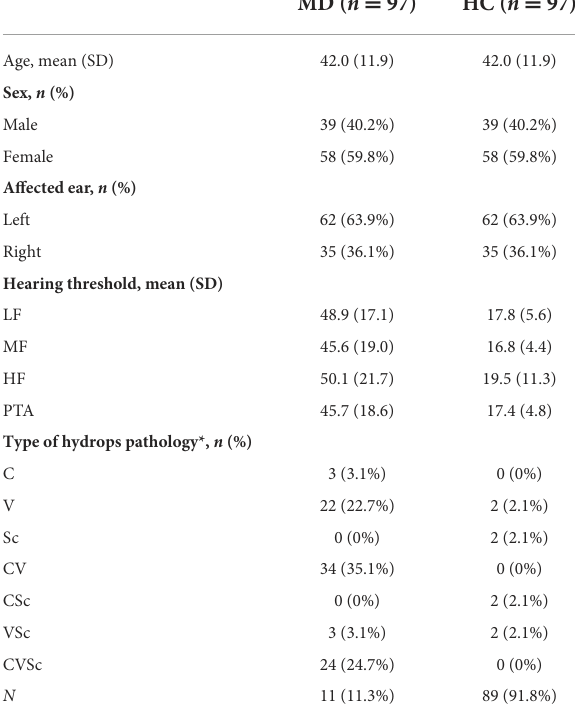
TABLE 2 Clinical features of all